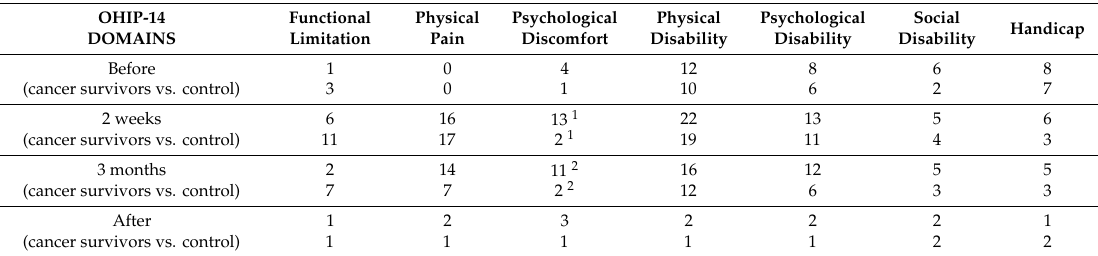
Physical Disability 12 10